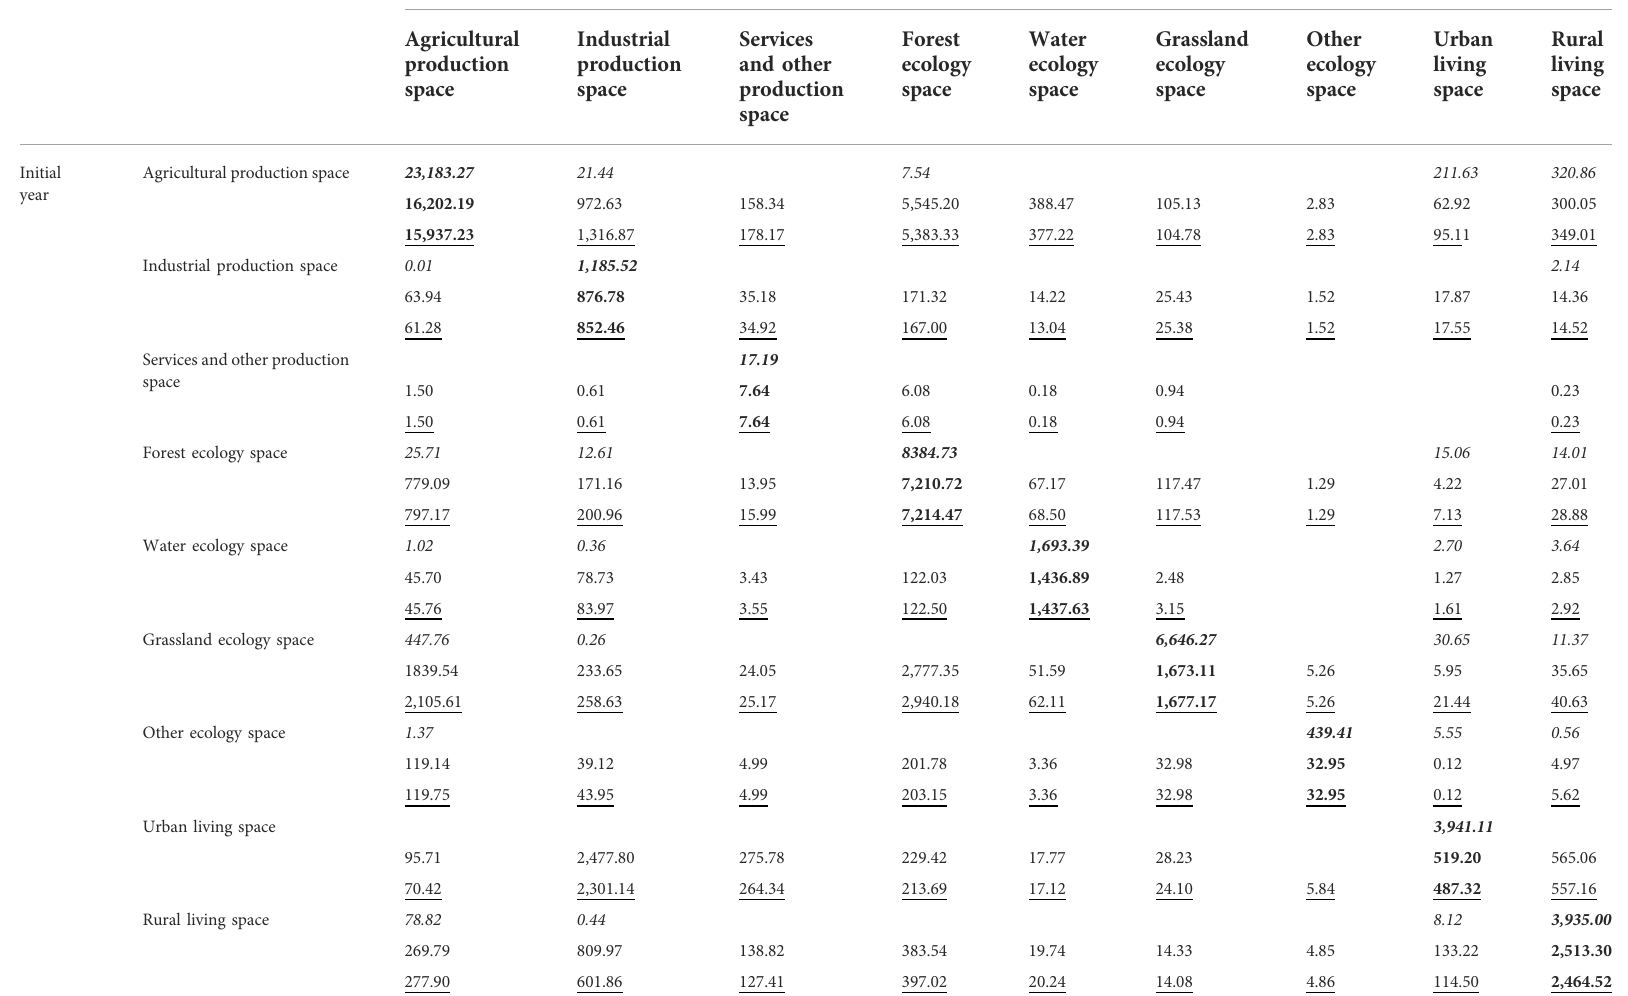
Rural living space